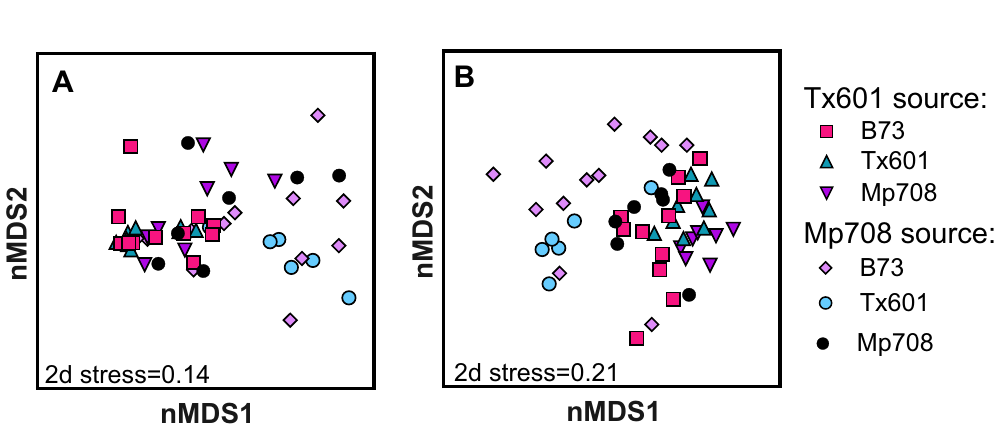
Figure 2. Non-metric multidimensional scaling of 16S-rRNA OTUs from guts of fall armyworm receiving transplants from donors that fed on maize genotypes Tx601 (susceptible) or Mp708 (resistant). Larvae were provided gamma-irradiated maize (see Fig. 3) and their gut microbiota were extracted and analyzed. Both Bray– Curtis ( A ) and Jaccard ( B ) distances were used to examine microbial structure and membership,